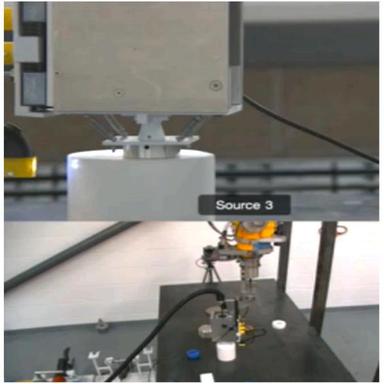
Robotic arm mounted contact Raman Probe, within simulated active hot cell on the M3000 robotic arm, taking a measurement on the sorting table. View from CCTV cameras 3 and 4 in the control room.